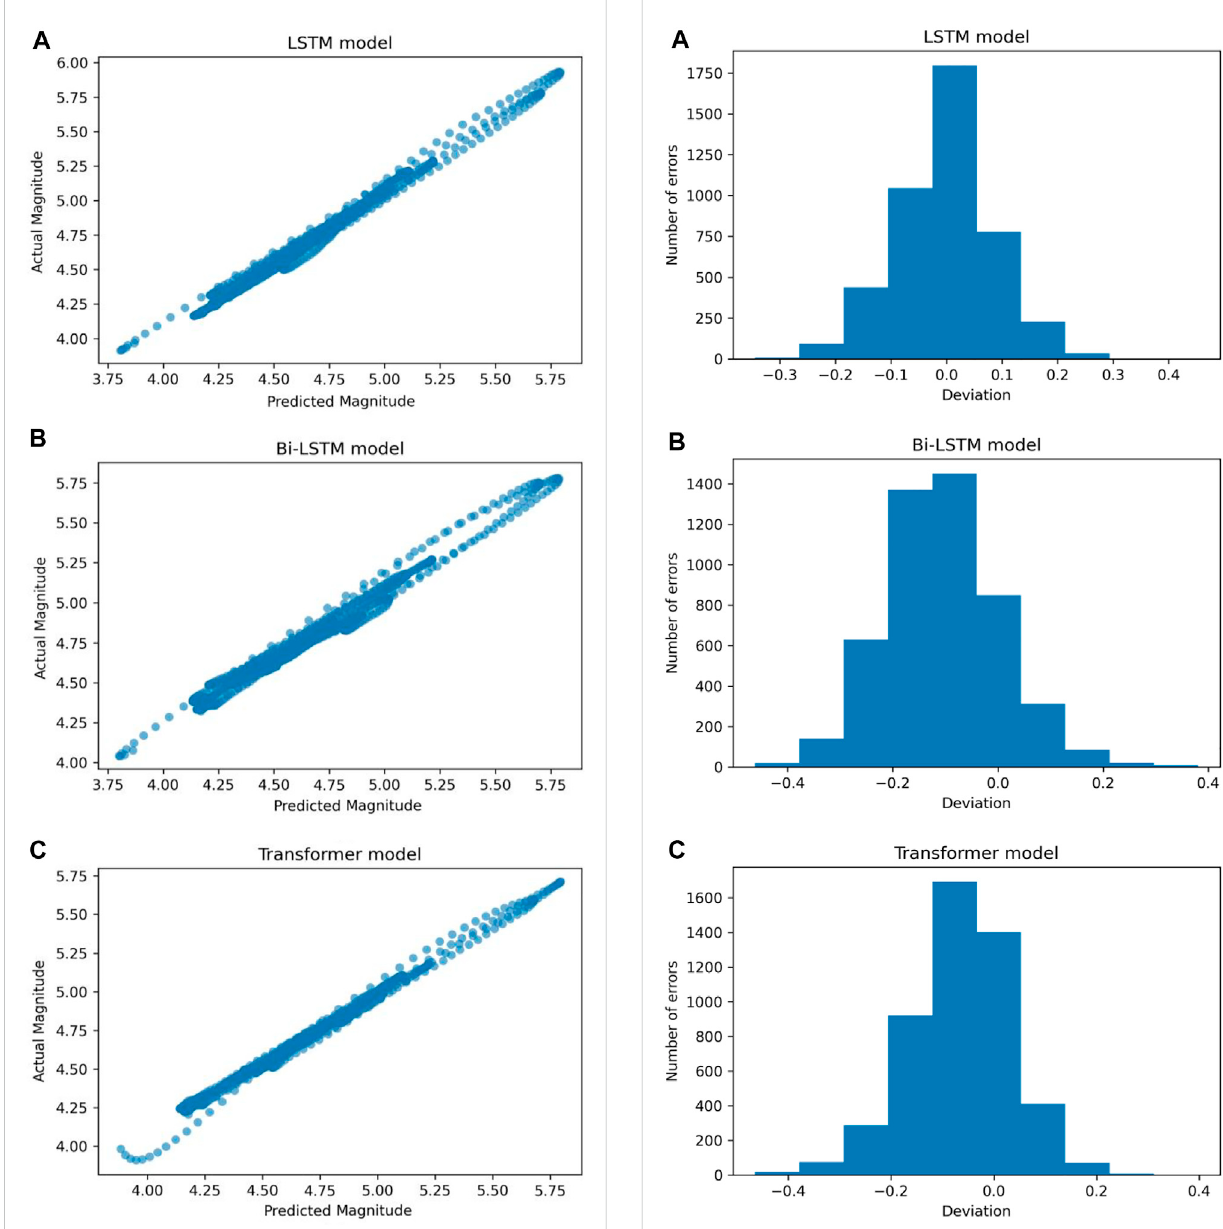
FIGURE 11 Plot of observed magnitude against anticipated magnitude utilizing (A) LSTM, (B) Bi-LSTM, and (C) transformer models on the Indonesia earthquake catalogue.